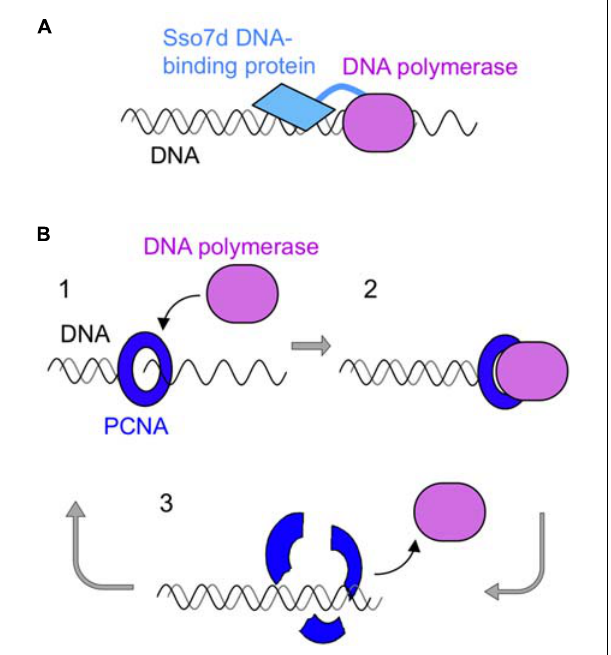
FIGURE 5 | Schematic diagrams of processive PCR using a family B DNA polymerase. (A) The DNA binding protein, Sso7d, from S. solfataricus was fused with Pfu polymerase to confer high processivity to this enzyme. (B) PCNA-assisted PCR. 1, Self-loading of mutant PCNA on DNA; 2, PCNA-assisted processive DNA synthesis; 3, disassembly of the complex after DNA